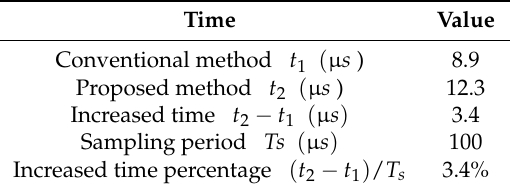
Table 2. Turnaround time comparison of the conventional method and the proposed